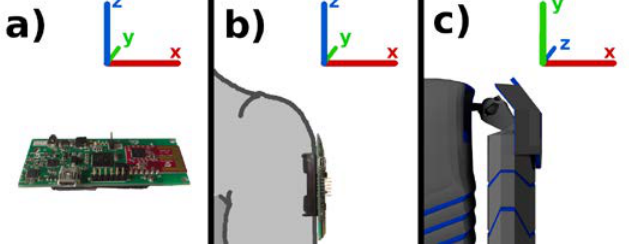
Figure 4. a) Global orientation of sensor on device startup. b) Sen- sor on the right upper arm with its global reference frame. c) Charac- ter’s arm orientation in Unity's axis